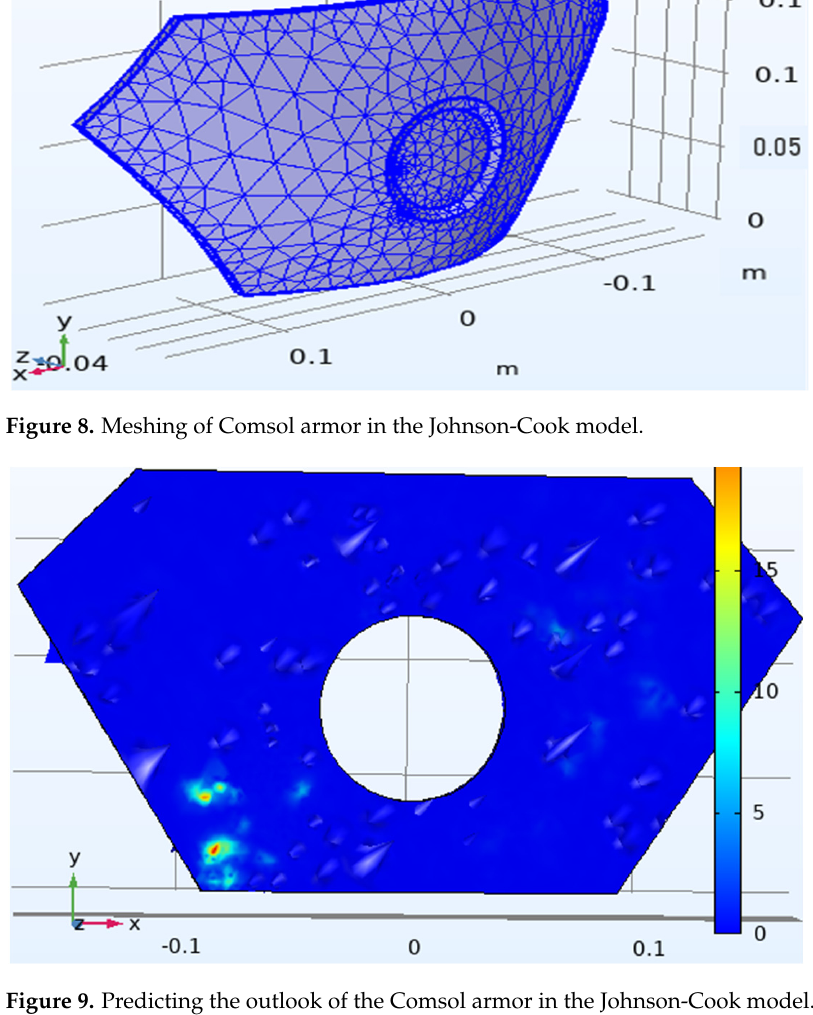
Figure 8. Meshing of Comsol armor in the Johnson-Cook model.